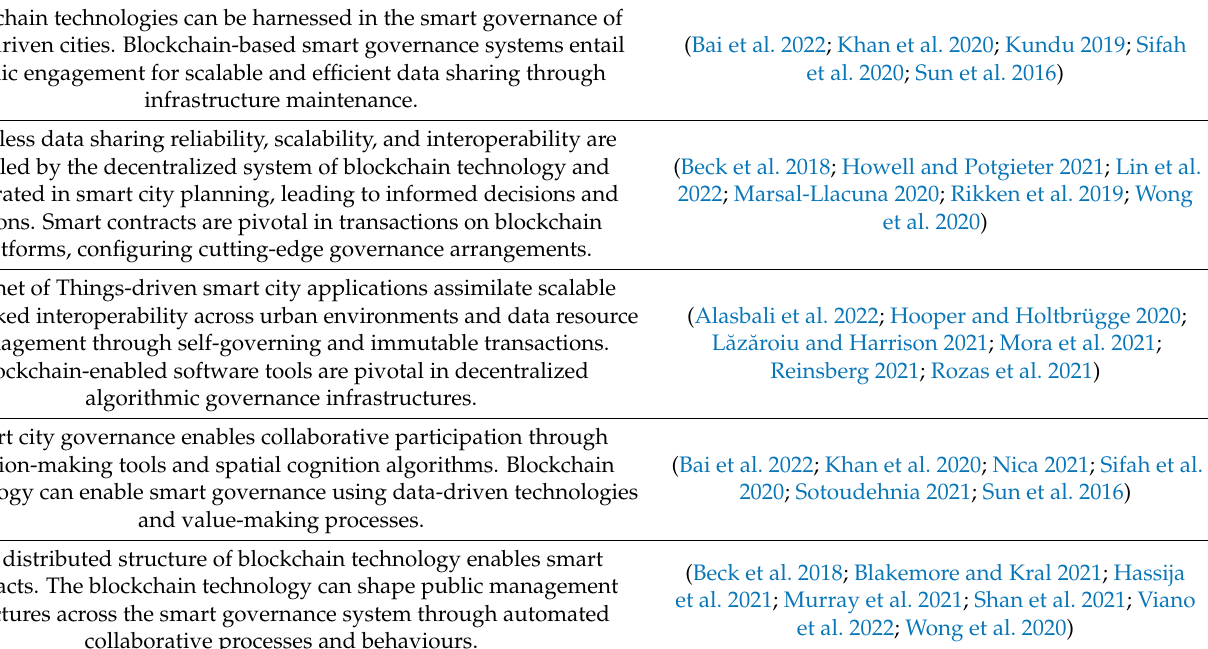
Table 2. General synopsis of evidence as regards focus topics and descriptive outcomes (research